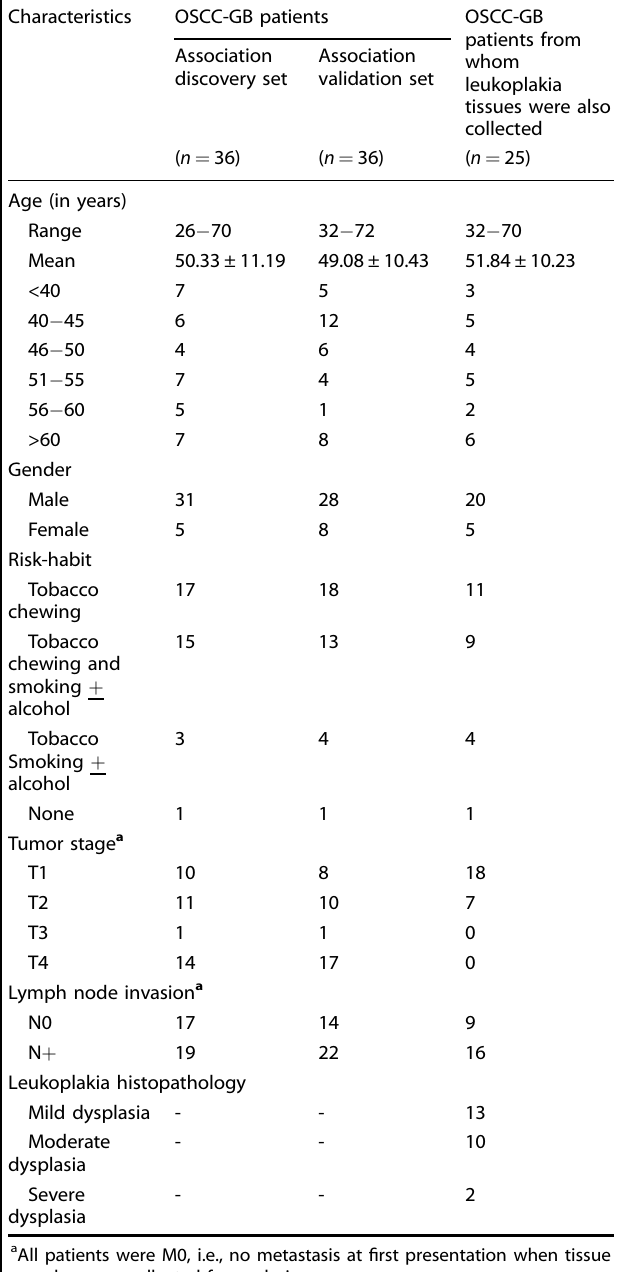
Table 1. Demographic and clinical characteristics of cohorts of study participants with OSCC-GB and premalignant lesion